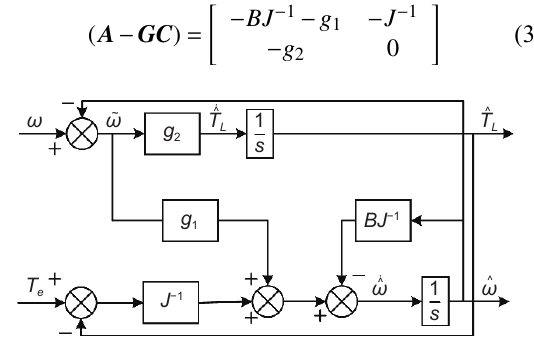
Fig. 6 Structure of the Luenberger load torque